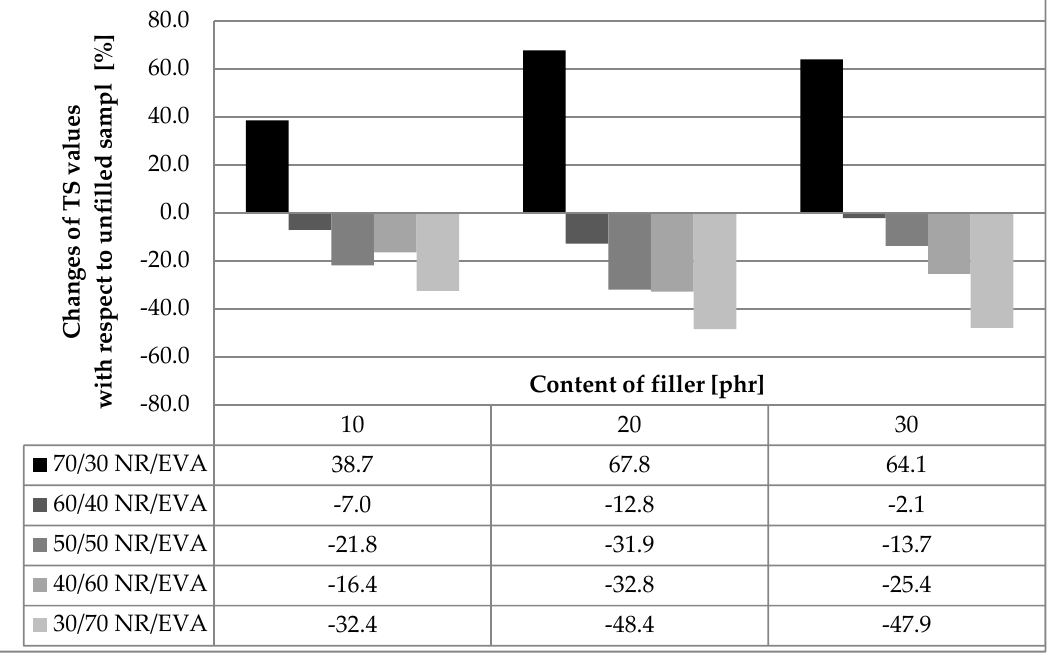
Figure 1. The percentage change in tensile strength for straw-based blend compared to unfilled systems.